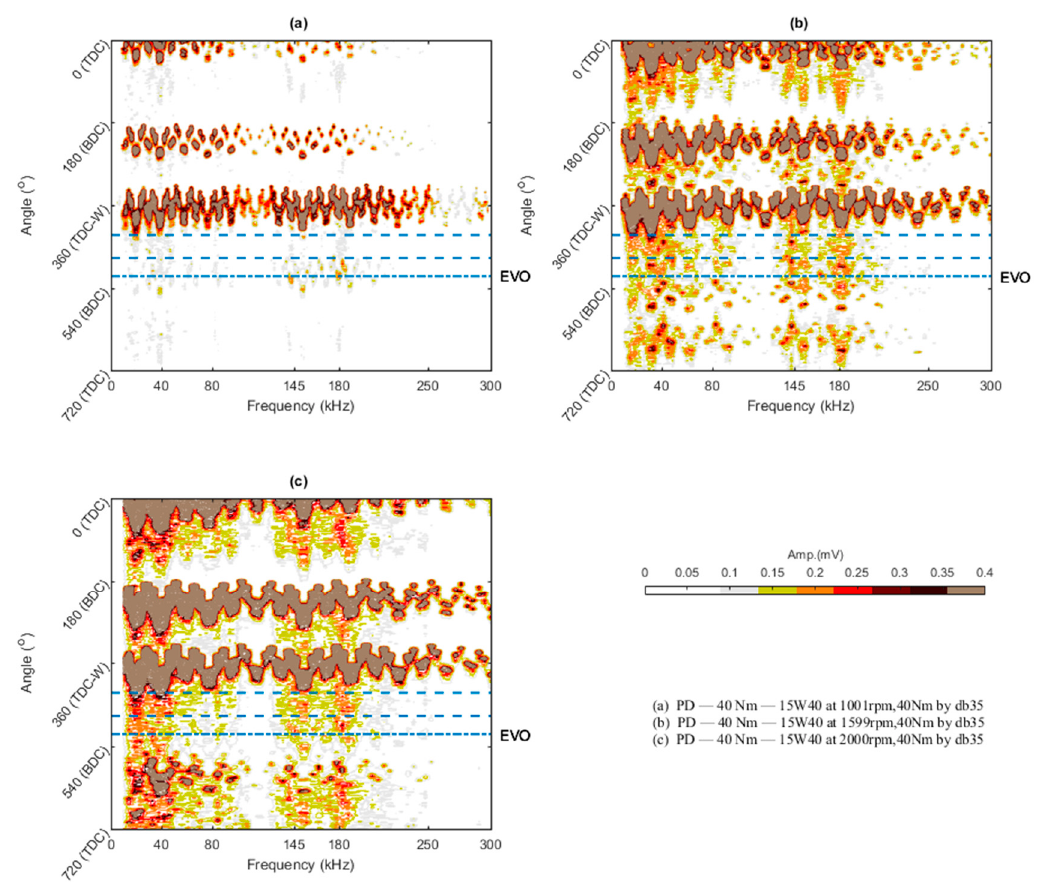
Figure 7. WPT spectra for 15W40 oil using db35 wavelet decomposed at level j = 7.